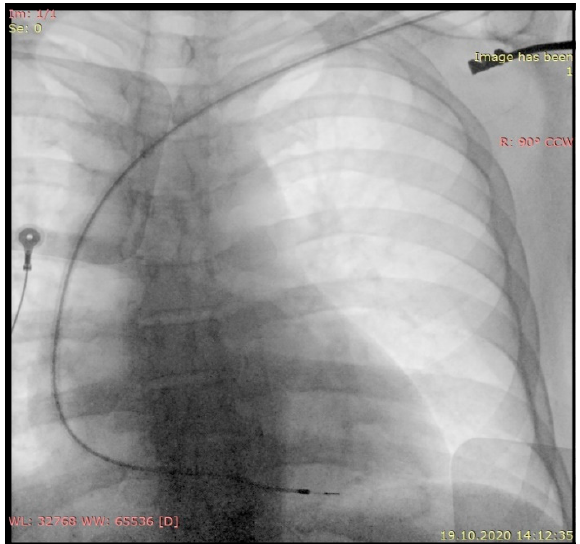
Figure 2. Antero-posterior chest X-ray: passive fixation lead on the topography of the right ventri- cle.